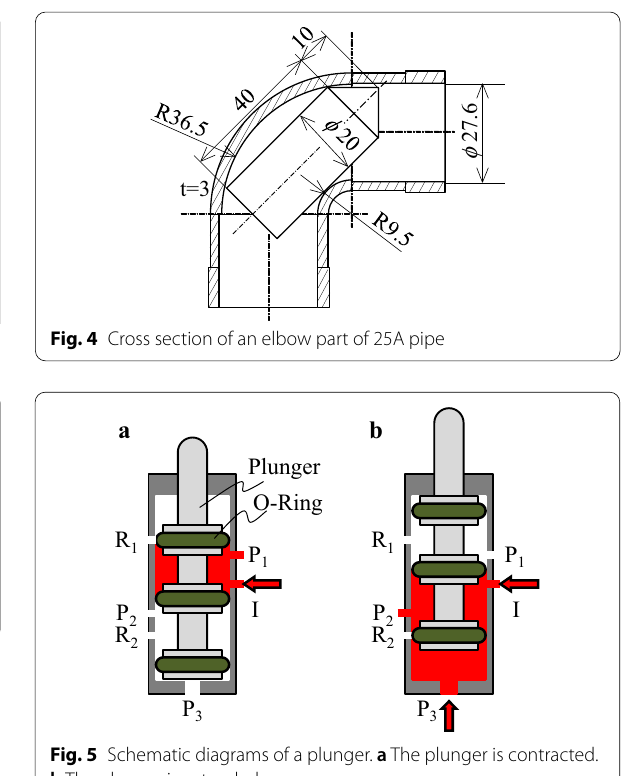
b The plunger is